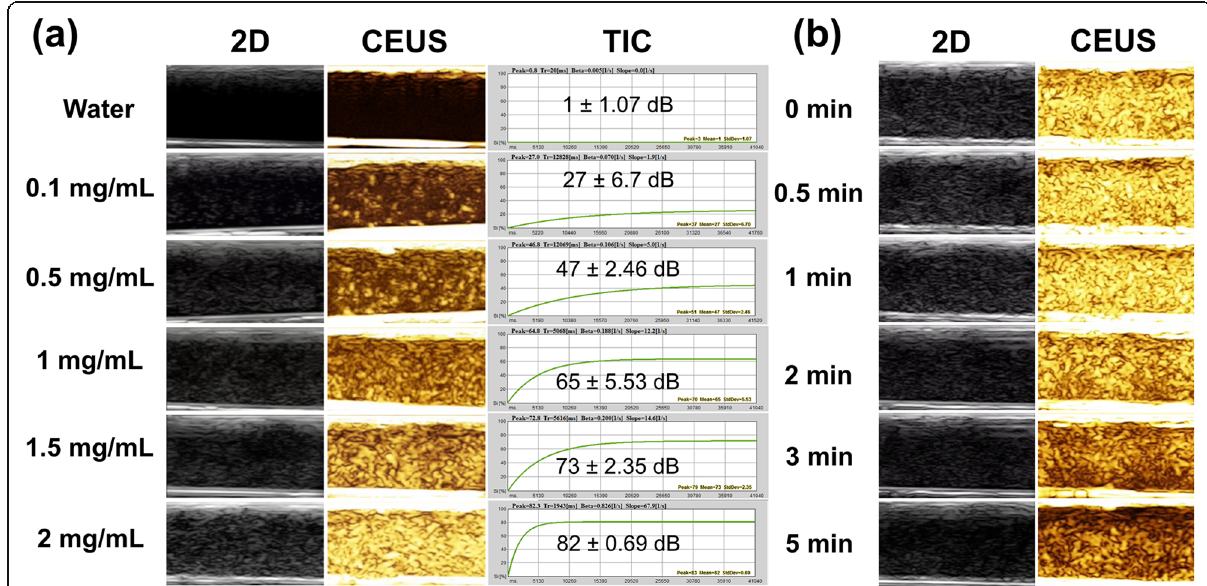
Fig. 8 a In vitro two-dimensional (2D) gray-scale ultrasound (US) and contrast-enhanced ultrasound (CEUS) images and the time-intensity curve (TIC) of Her2-GPH NPs under different concentrations (0, 0.1, 1, 1.5, 2mg/mL). b In vitro US images of Her2-GPH NPs (2mg/mL) with time